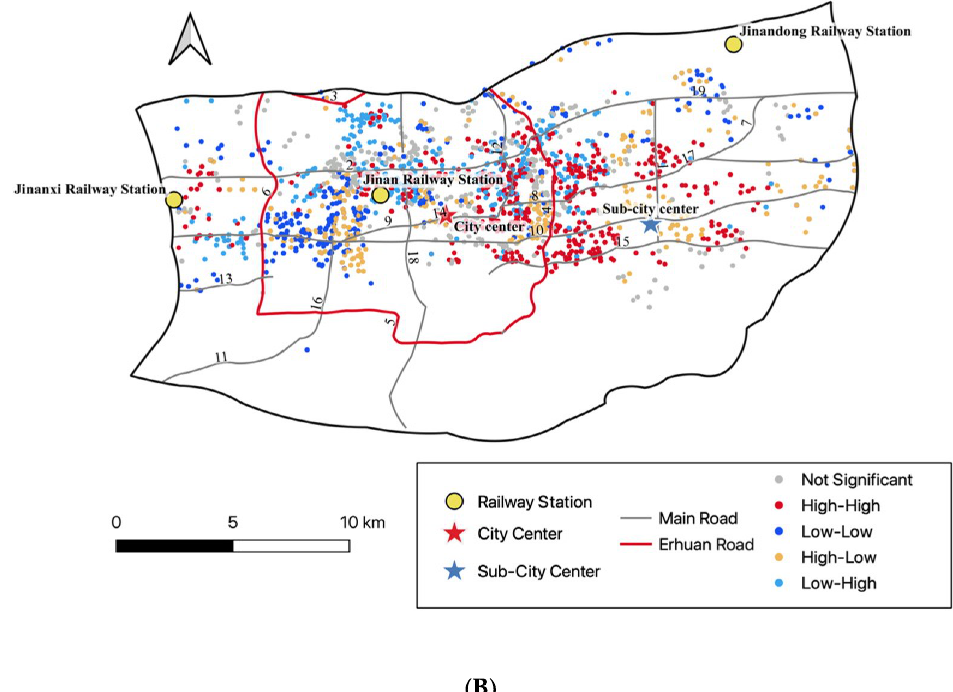
Figure 3. Local autocorrelation characteristics of residential rents ( A ). Local autocorrelation charac- teristics between residential rents and walking accessibility ( B